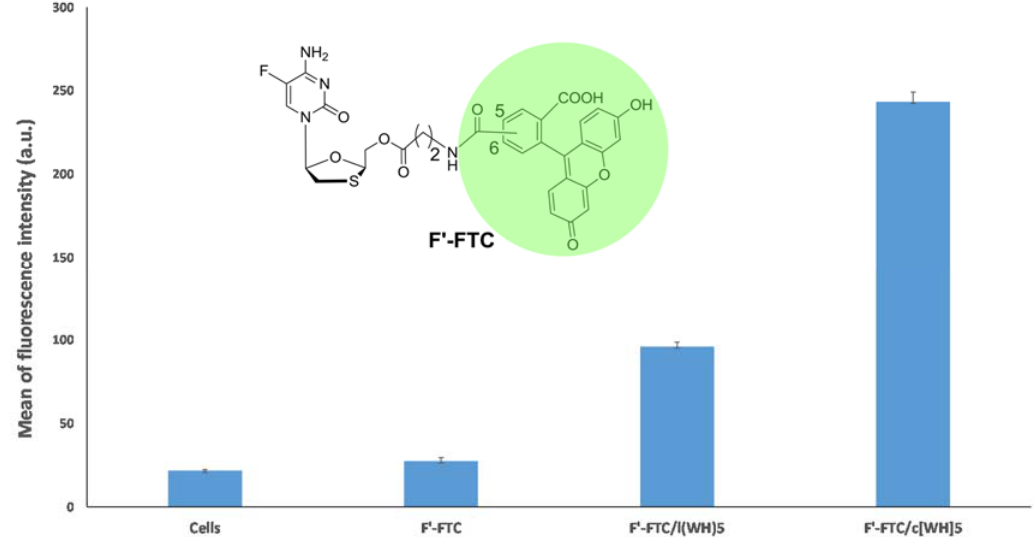
Figure 3. Intracellular uptake of F’ ‐ FTC by linear (WH) 5 and cyclic [WH] 5 in SK ‐ OV ‐ 3 cancer cell lines.